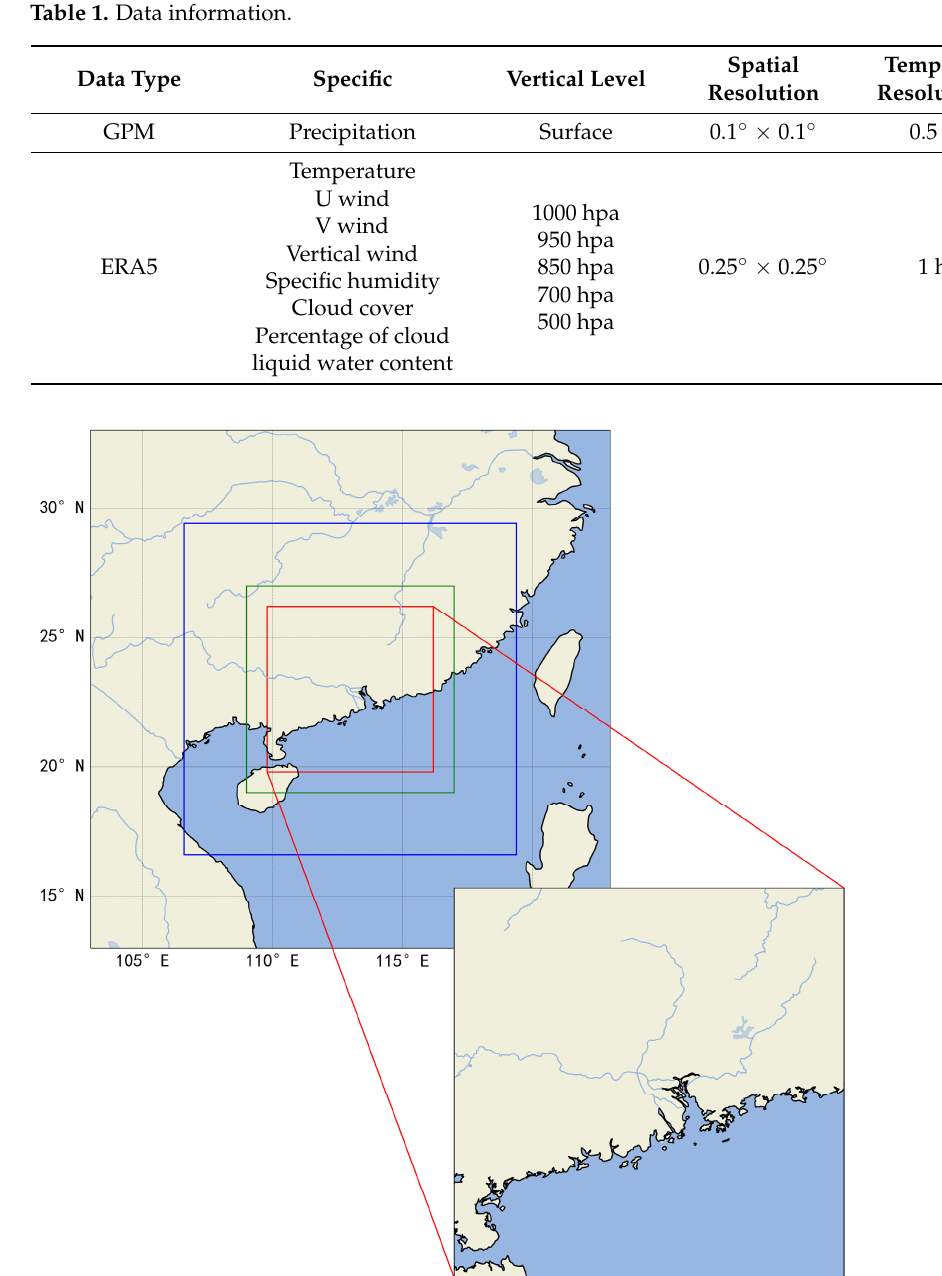
Table 1. Data information.